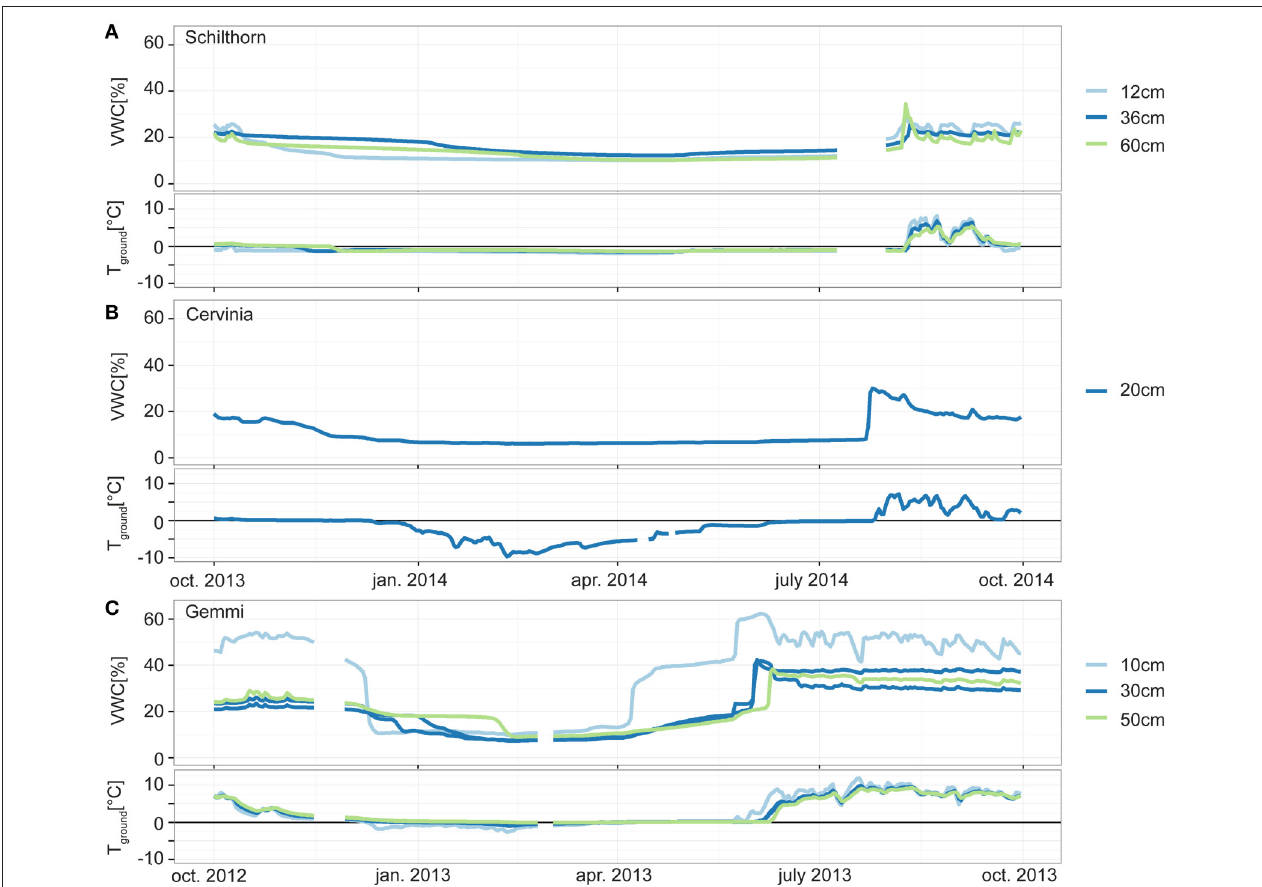
FIGURE 3 | Temporal evolution of the measured soil moisture (upper panel) and ground temperature (lower panel) at (A) Schilthorn, (B) Cervinia, and (C) Gemmi for the year 2013 (A,B) and 2014 (C). Missing data prevented the use of the same time period for each site and the gaps were too large to apply gap-filling